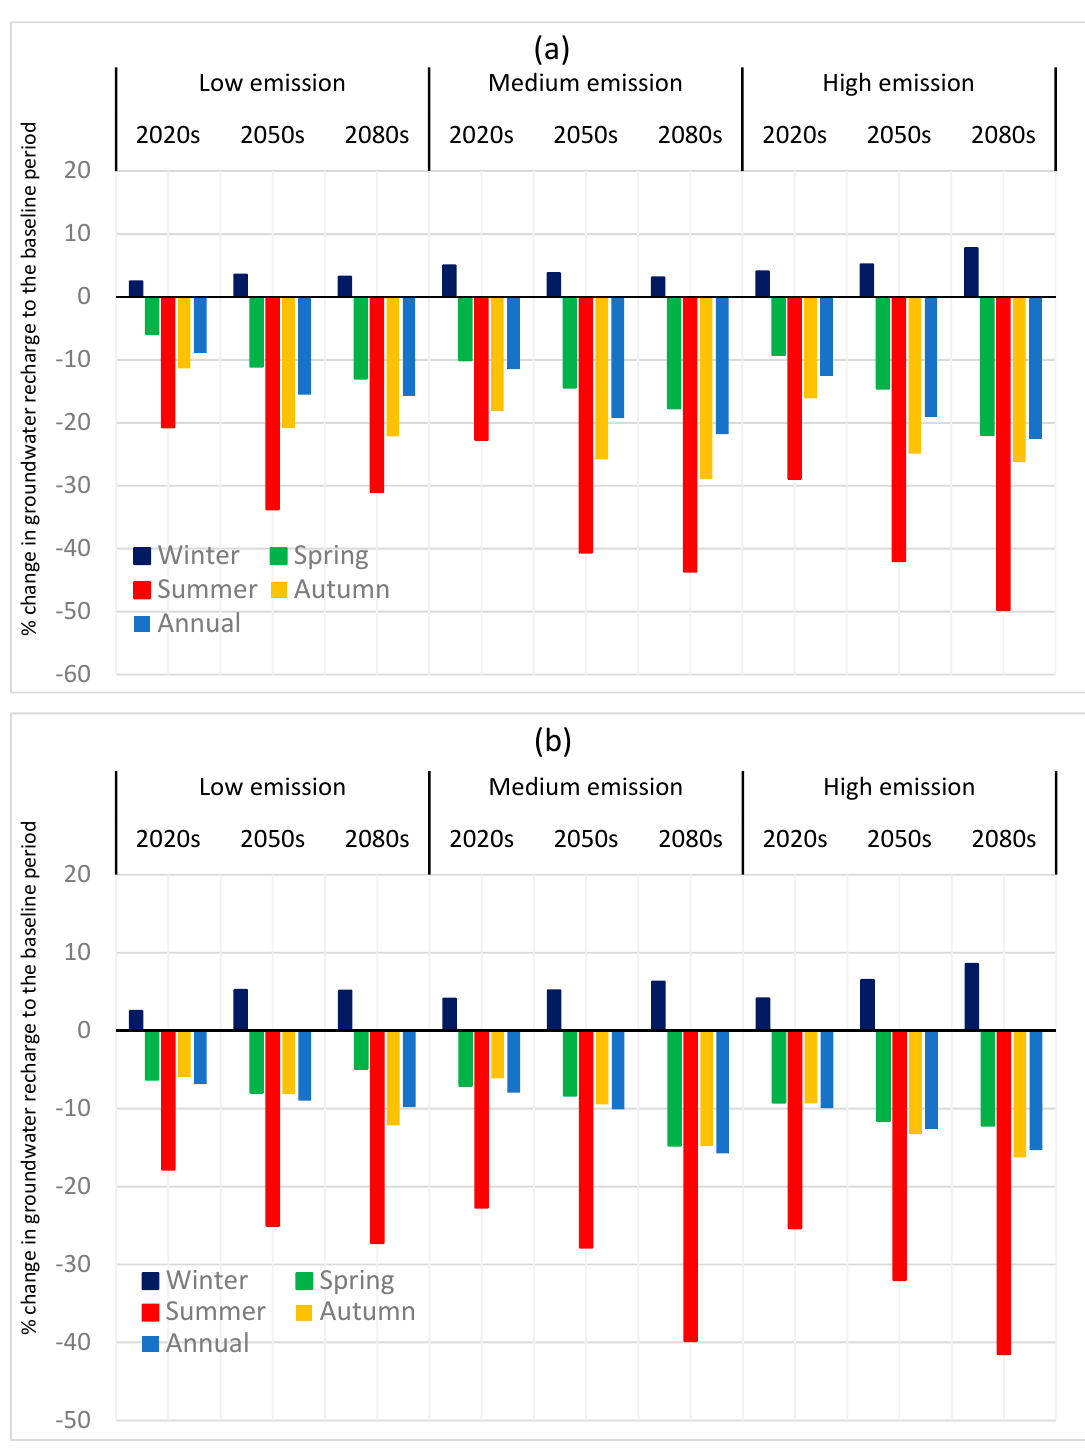
Figure 12. Changes in groundwater recharge using joint probability ( a ) and weather generator ( b ) data of the UKCP09 different climate change scenarios.